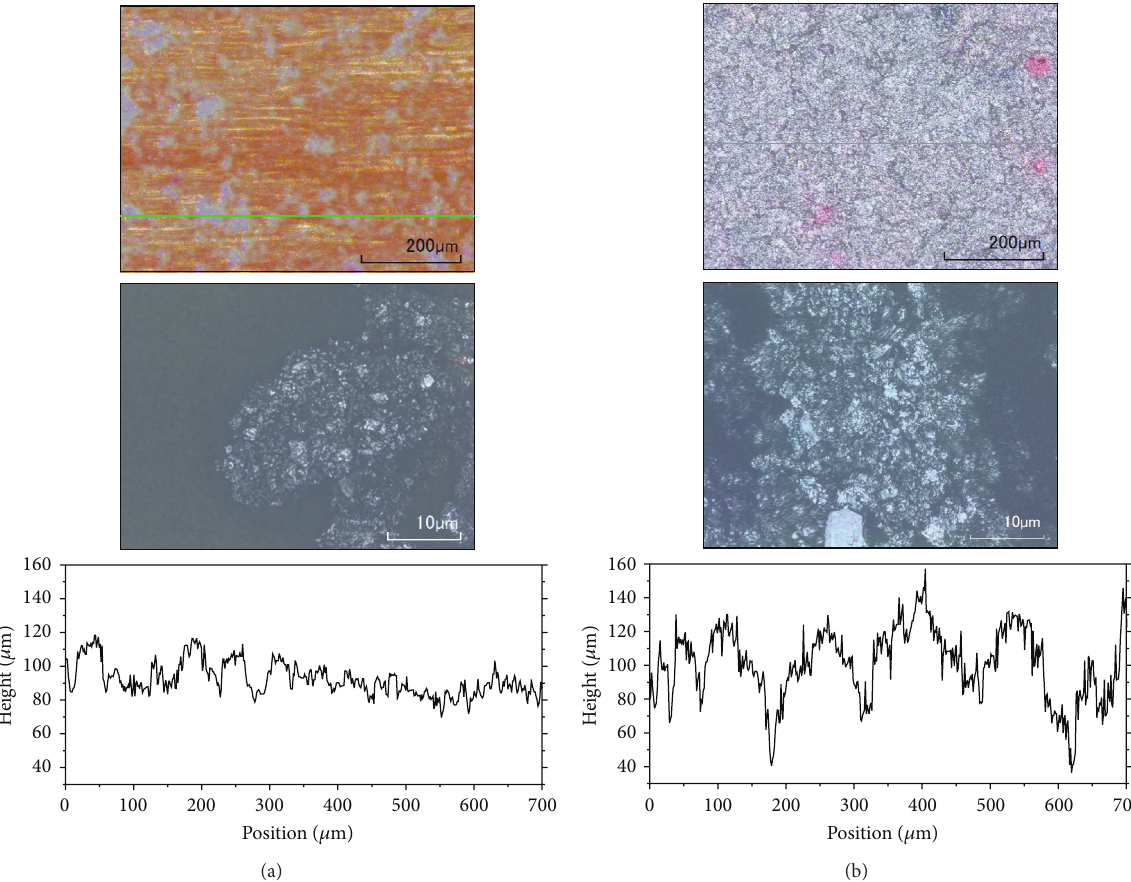
Figure 6: (a) CLSM images of a thin plasma coating on a beech wood substrate (sample A) at optical magnifications of 100x (top) and 1500x (middle) as well as a height profile along the green line within the top image. (b) CLSM images of a thick plasma coating on a beech wood substrate (sample C) at optical magnifications of 100x (top) and 1500x (middle) as well as a height profile along the green line within the top